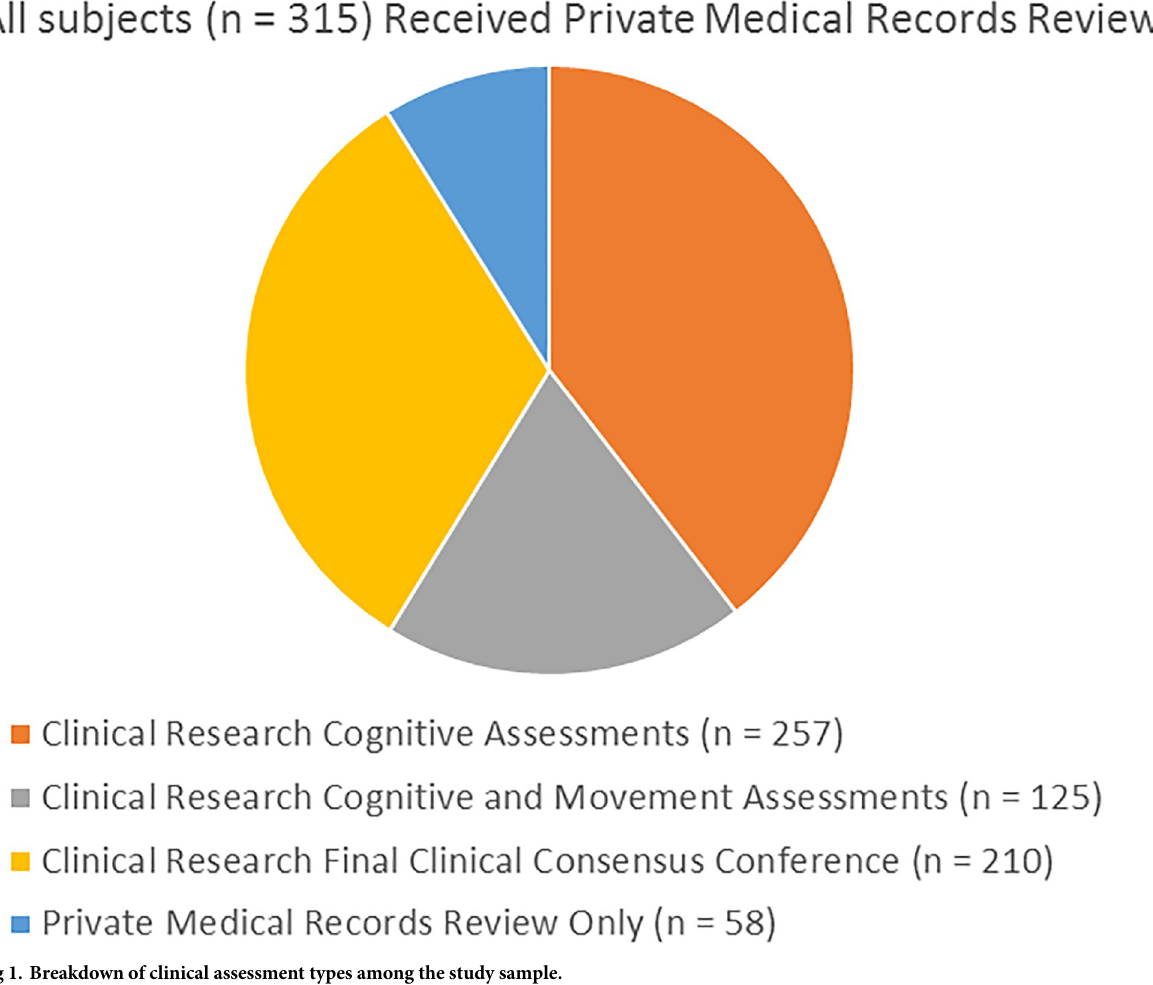
Fig 1. Breakdown of clinical assessment types among the study